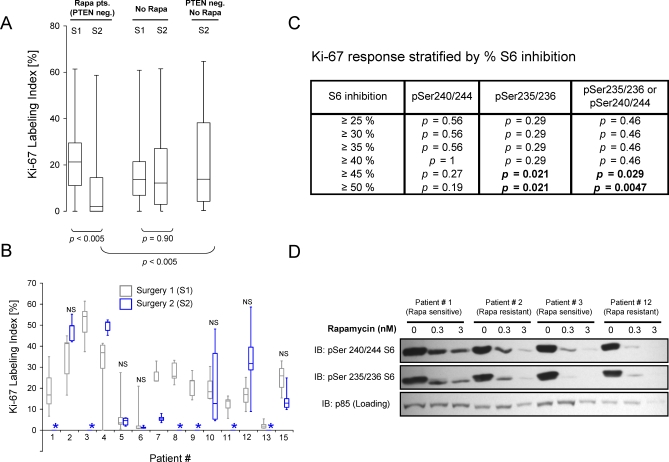
Rapamycin Inhibits Tumor Cell Proliferation in Subsets of PTEN-Deficient GBMs(A) Ki-67 labeling index of GBMs before (S1) and during (S2) rapamycin therapy compared with tumor samples from patients who did not receive rapamycin (see text for detail). The horizontal line inside a box plot shows the median value. The lower and upper end of the box corresponds to the 25th and 75th percentile, respectively. The whiskers extend to the 95% range. The Wilcoxon nonparametric group comparison test was used to calculate p-values for the differences between different patient groups.(B) Changes in tumor cell proliferation between S1 and S2 for 14/15 rapamycin patients. The horizontal line inside the box indicates the median value. The lower and upper border of the box corresponds to the 25th and 75th percentile, respectively. The whiskers extend to the 95% range. Paraffin blocks from patient 14 were not sufficient for quantification. The median Ki-67 labeling index of the S2 specimen from patients 1, 3, 8, 9, 11, and 13 was 0 (indicated by asterix). N.S. indicates that the difference in Ki-67 labeling index not statistically significant at the 0.05 level according to the Wilcoxon test.(C) Relationship between the magnitude of S6 inhibition and Ki-67 response in S2 tumor samples from rapamycin-treated patients. p-values were determined by Fisher Exact test for different thresholds of pS6 inhibition.(D) Ex vivo rapamycin response of short-term cultures derived from tumors with in vivo S6 response (patients 1 and 3) or resistance (patients 2 and 12). Shown are S6 and p85 (loading) immunoblots of whole cell lysates 8 h after treatment with vehicle, 0.3 nM rapamycin, and 3 nM rapamycin.